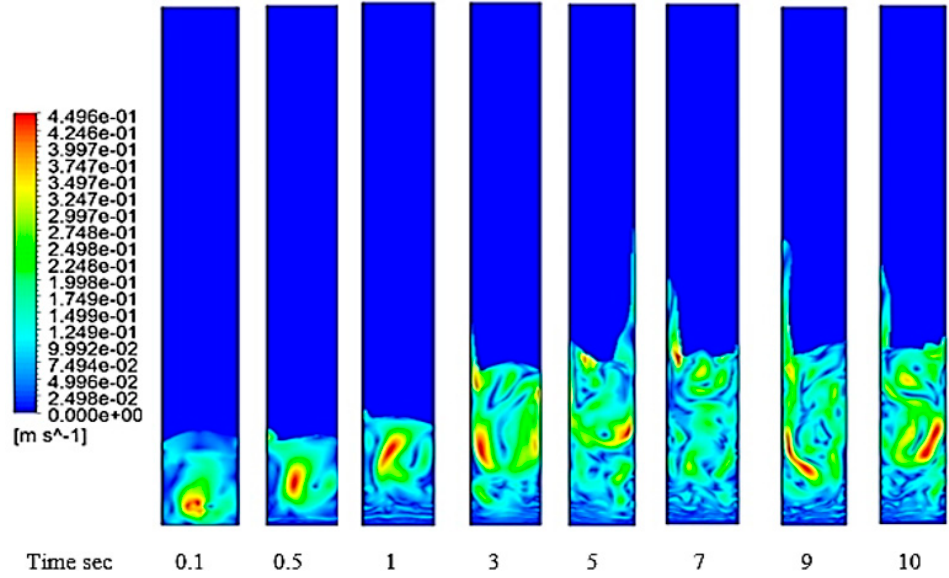
Figure 15. The velocity contour of particles with a diameter of 4 mm with time.